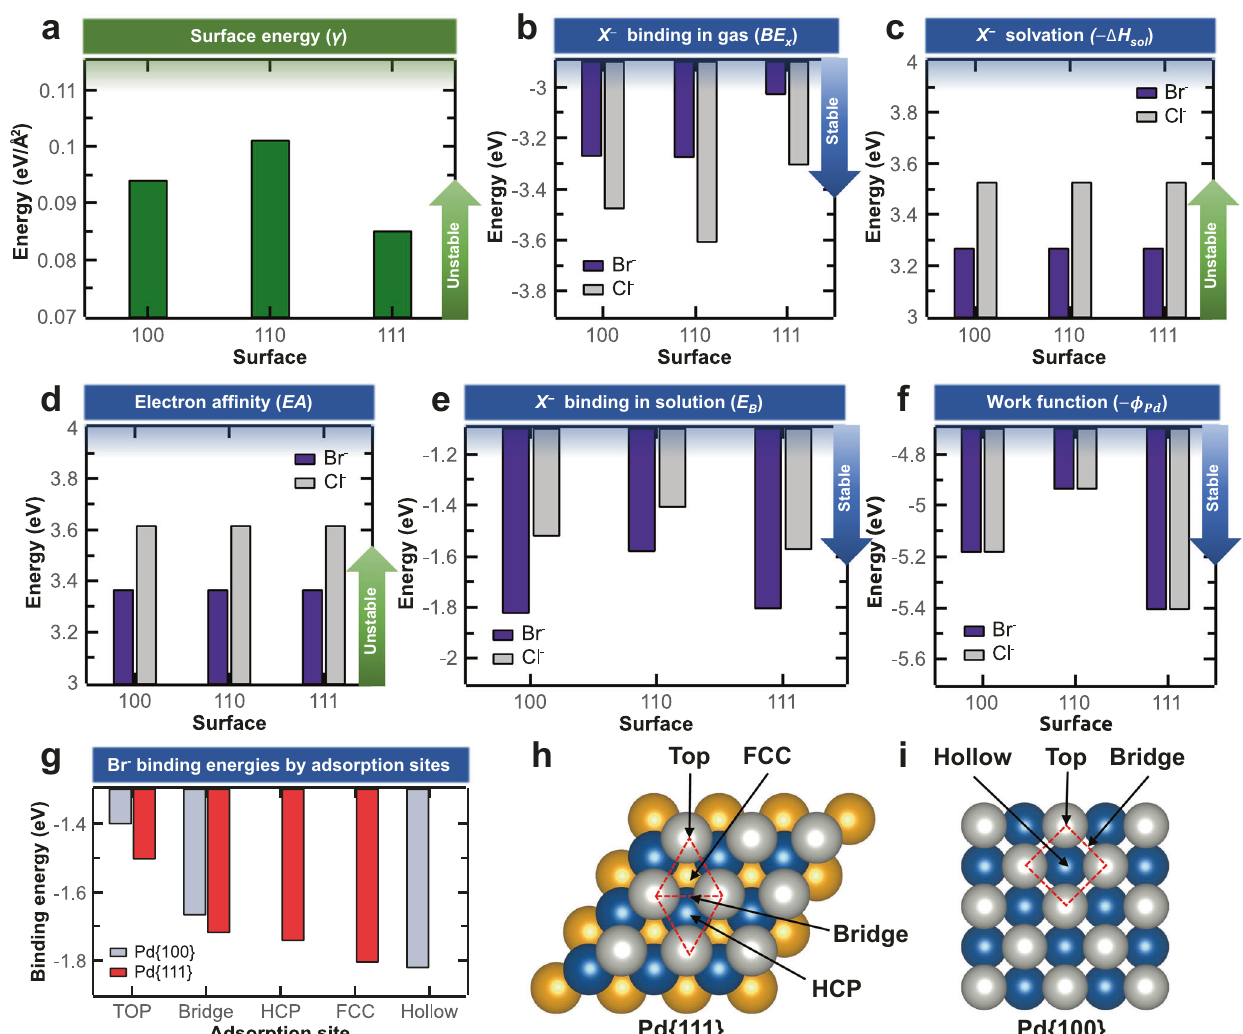
Fig. 4 Density functional theory calculations. a Surface energy values for Pd {100}, {110}, and {111} facets. b Binding energies of halide anions on Pd in a vacuum. c Solvation energies of halide anions. d Electron af fi nities of halide anions. e Binding energies of halide anions on Pd in solutions. f Work functions of Pd surfaces. g Binding energies of Br – for the different adsorption sites of Pd surfaces; h , i Corresponding adsorption sites (face-centered cubic (FCC), hexagonal close-packed (HCP), bridge, and top) for Pd {111} and {100} facets from a top